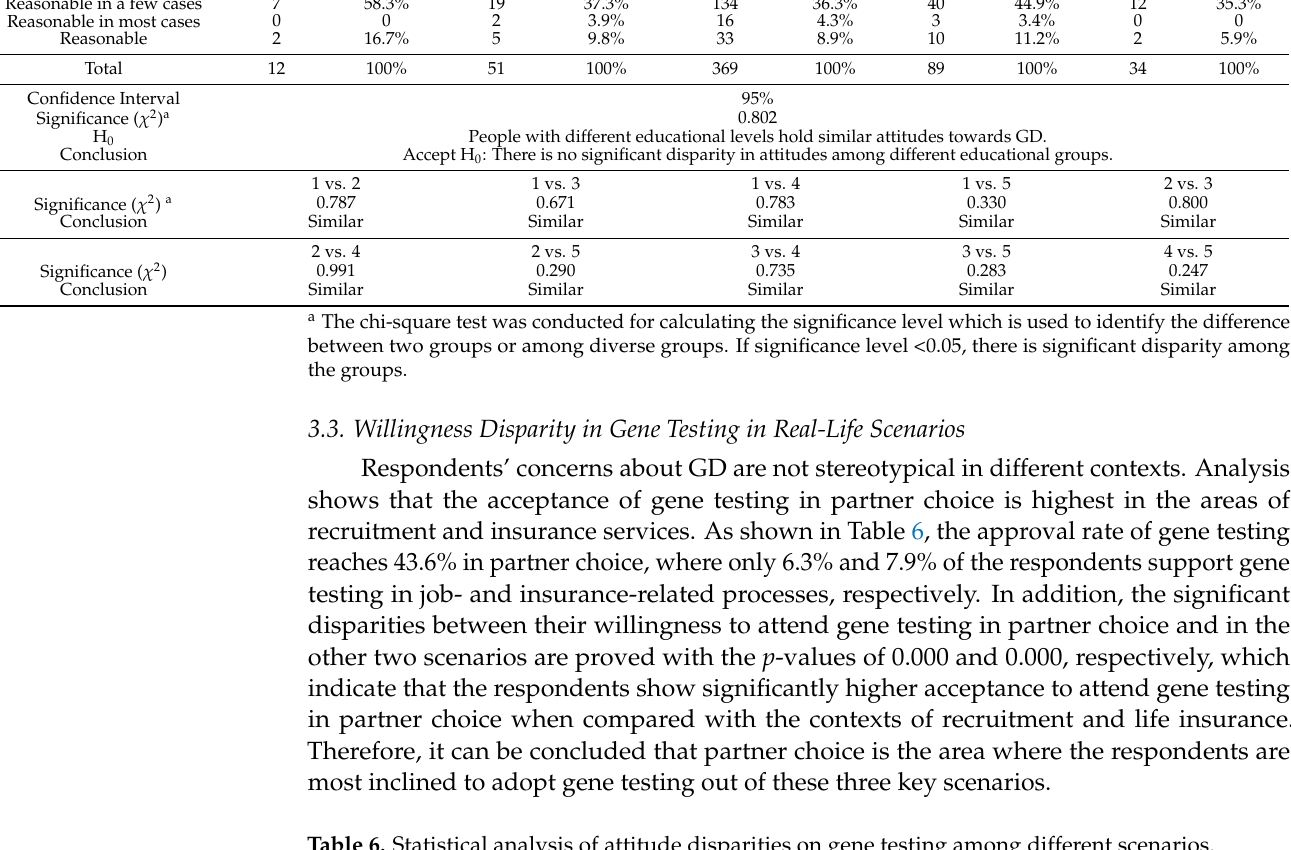
Table 6. Statistical analysis of attitude disparities on gene testing among different